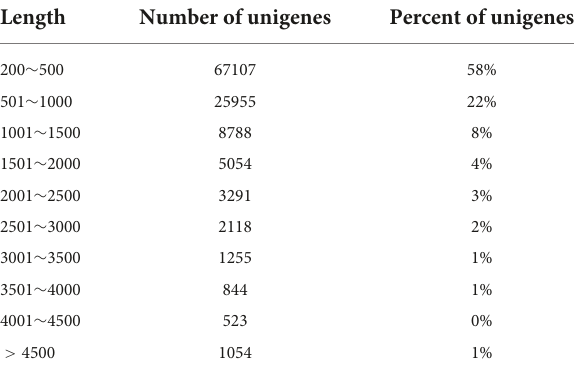
TABLE 1 Length distribution of assembled